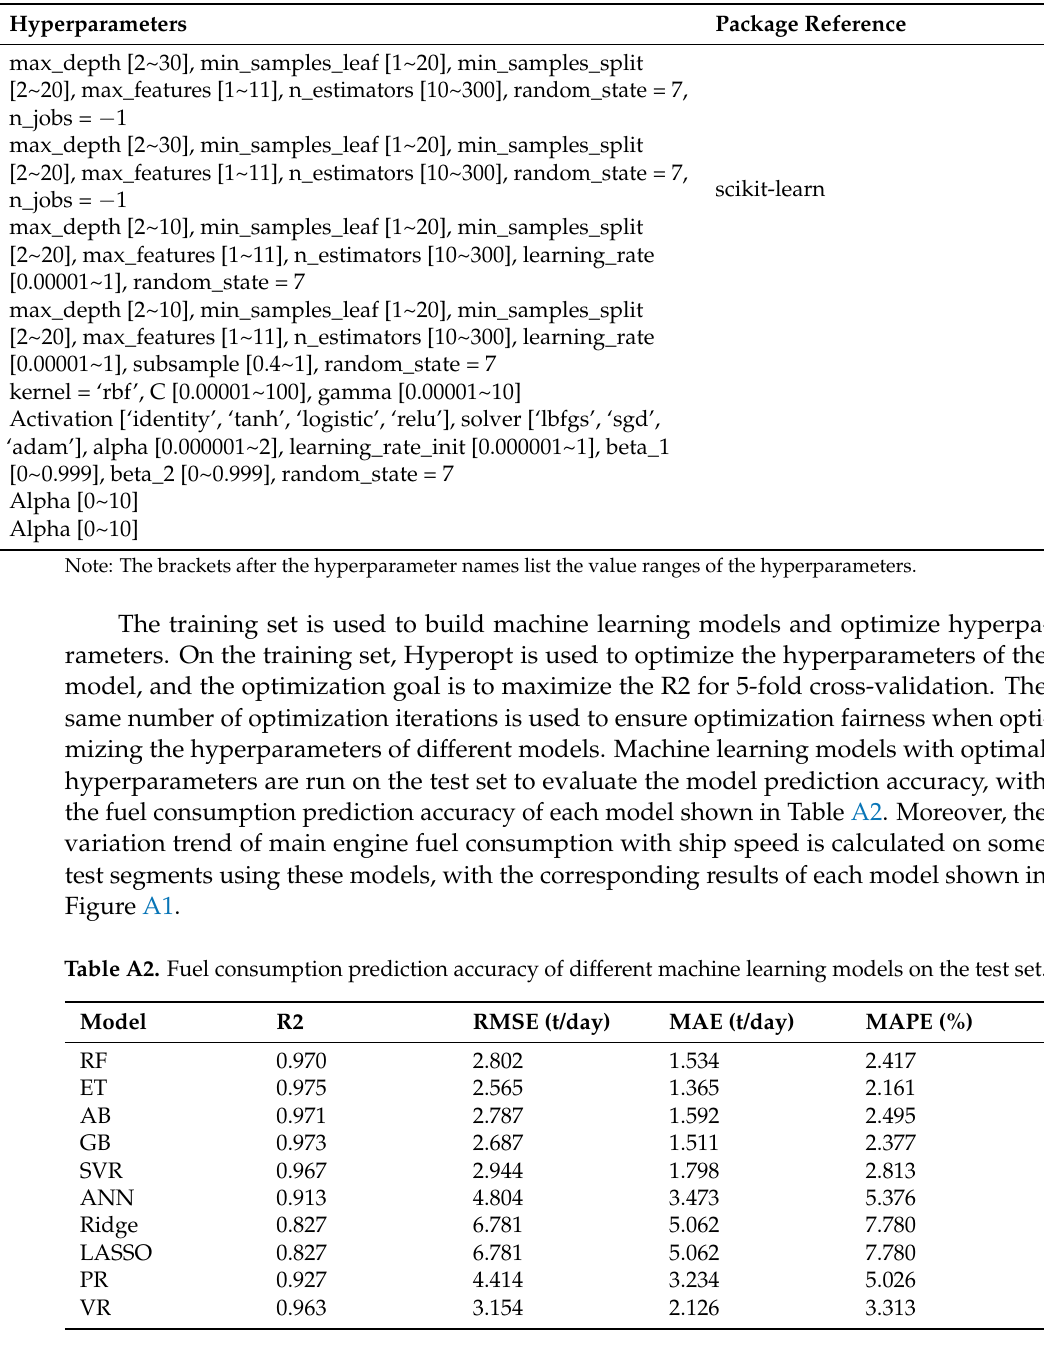
Table A1. Model hyperparameters to be optimized.